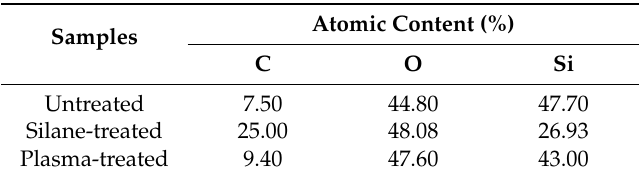
Table 2. Atomic concentrations of nanoparticles after treatment.